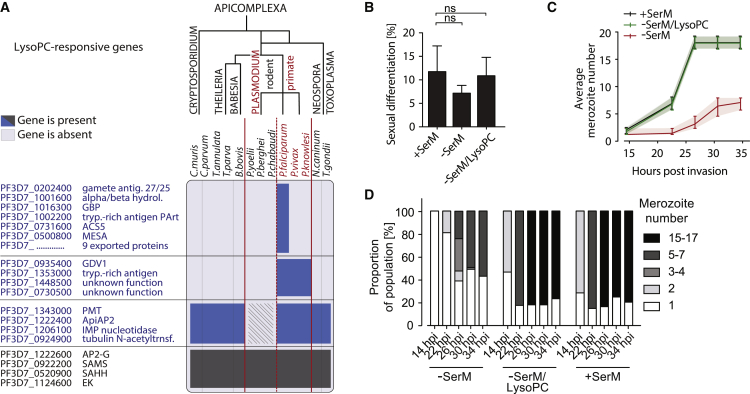
LysoPC Is Metabolized, but Does Not Control Differentiation, in Rodent Malaria Parasites(A) Phylogenetic analysis reveals loss of key LysoPC-responsive genes in the rodent malaria lineage. Lineage-specific losses are marked by hatched area.(B) LysoPC does not affect sexual differentiation of rodent parasites. Gametocyte production of P. berghei parasites in response to different ex vivo culture conditions (+SerM, −SerM, or −SerM/LysoPC) is shown. Effect on sexual differentiation was measured after parasites were delivered into a recipient mouse. n = 5, standard deviations are shown, (ns, not significant; Student’s t test).(C and D) LysoPC depletion reduces number of progeny in P. berghei. Growth response to different ex vivo culture conditions (+SerM, −SerM, or −SerM/LysoPC) is shown. (C) Average merozoite counts per infected erythrocyte were quantified after subtracting gametocyte-infected cells (single nucleated cells in +SerM condition at 30 hpi were used to define gametocyte proportion in samples). Interquartile ranges are shown. (D) Merozoite number was quantified per infected erythrocyte and assigned to one of five categories (indicated). Shown are relative proportions of each category. Merozoites of 30–65 infected erythrocytes were counted per time point.